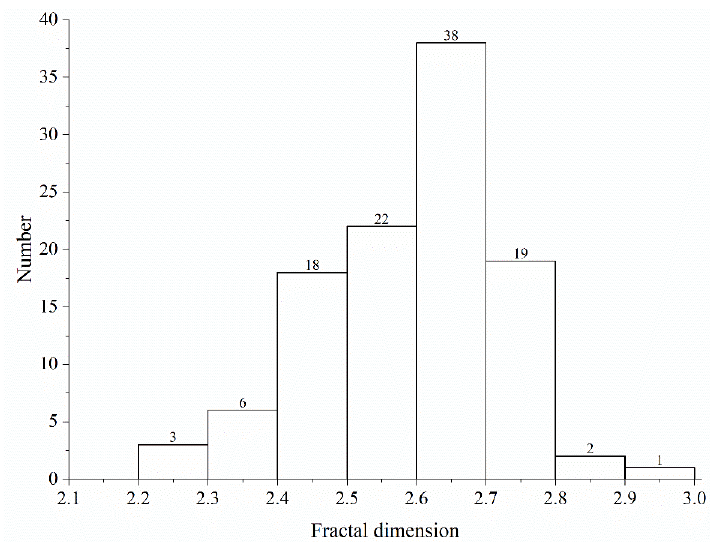
Figure 12. Frequency histogram of the fractal dimensions of the SRM in Southwest China.